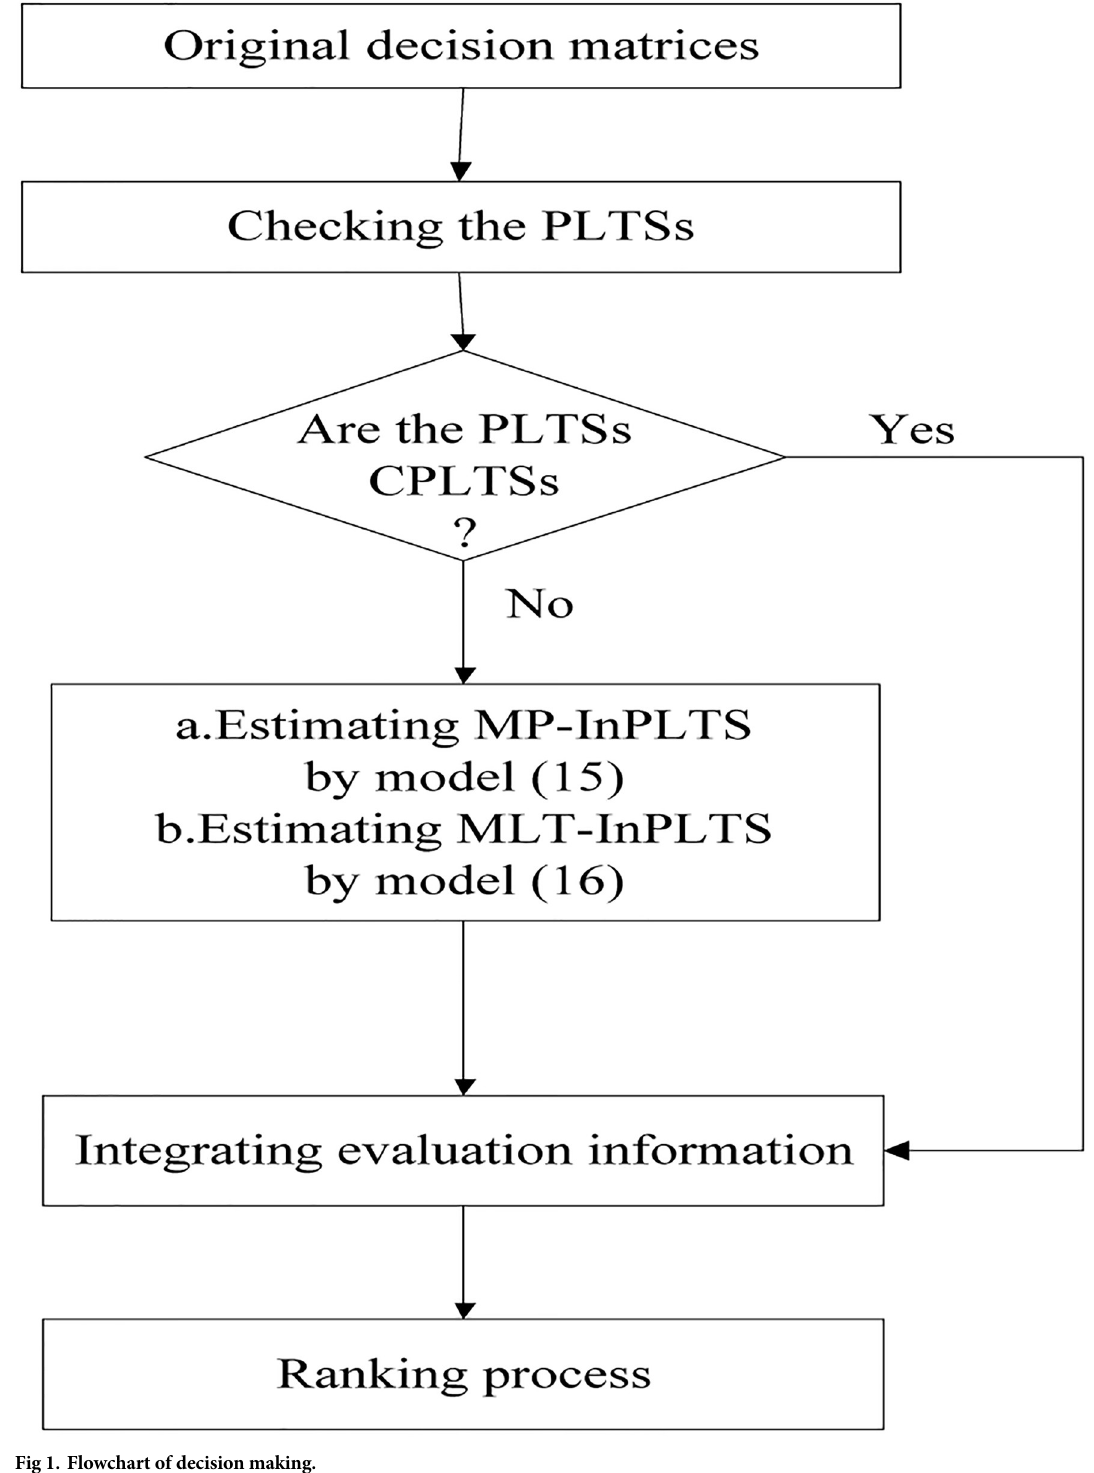
Fig 1. Flowchart of decision